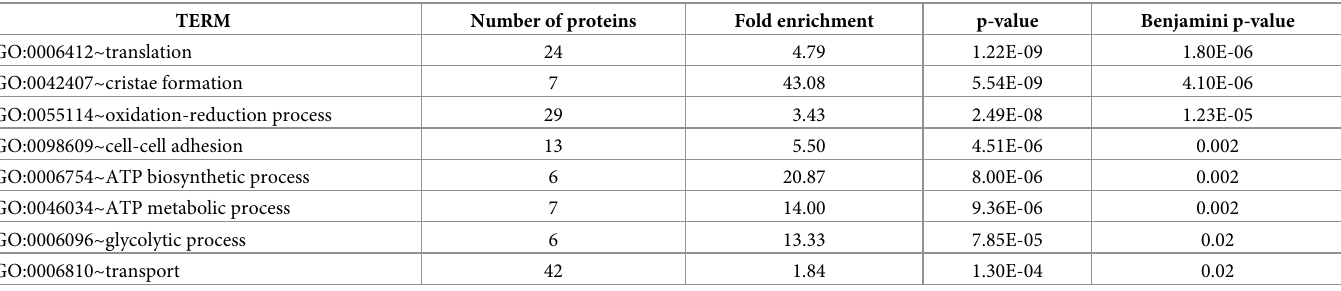
Table 1. Biological processes with significant overexpression for putative O-GlcNAcylated protein changes during pressure overload hypertrophy (POH). TERM